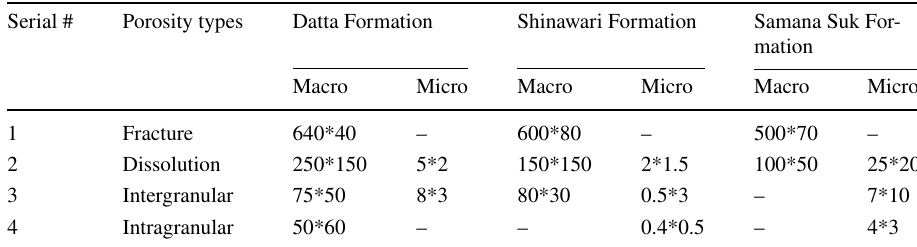
Table 5 Macro- and micro- porosity distribution using conventional thin-section petrography (macro) and scanning electron microscopy (micro) of the Jurassic Datta, Shinawari, and Samana Suk formations